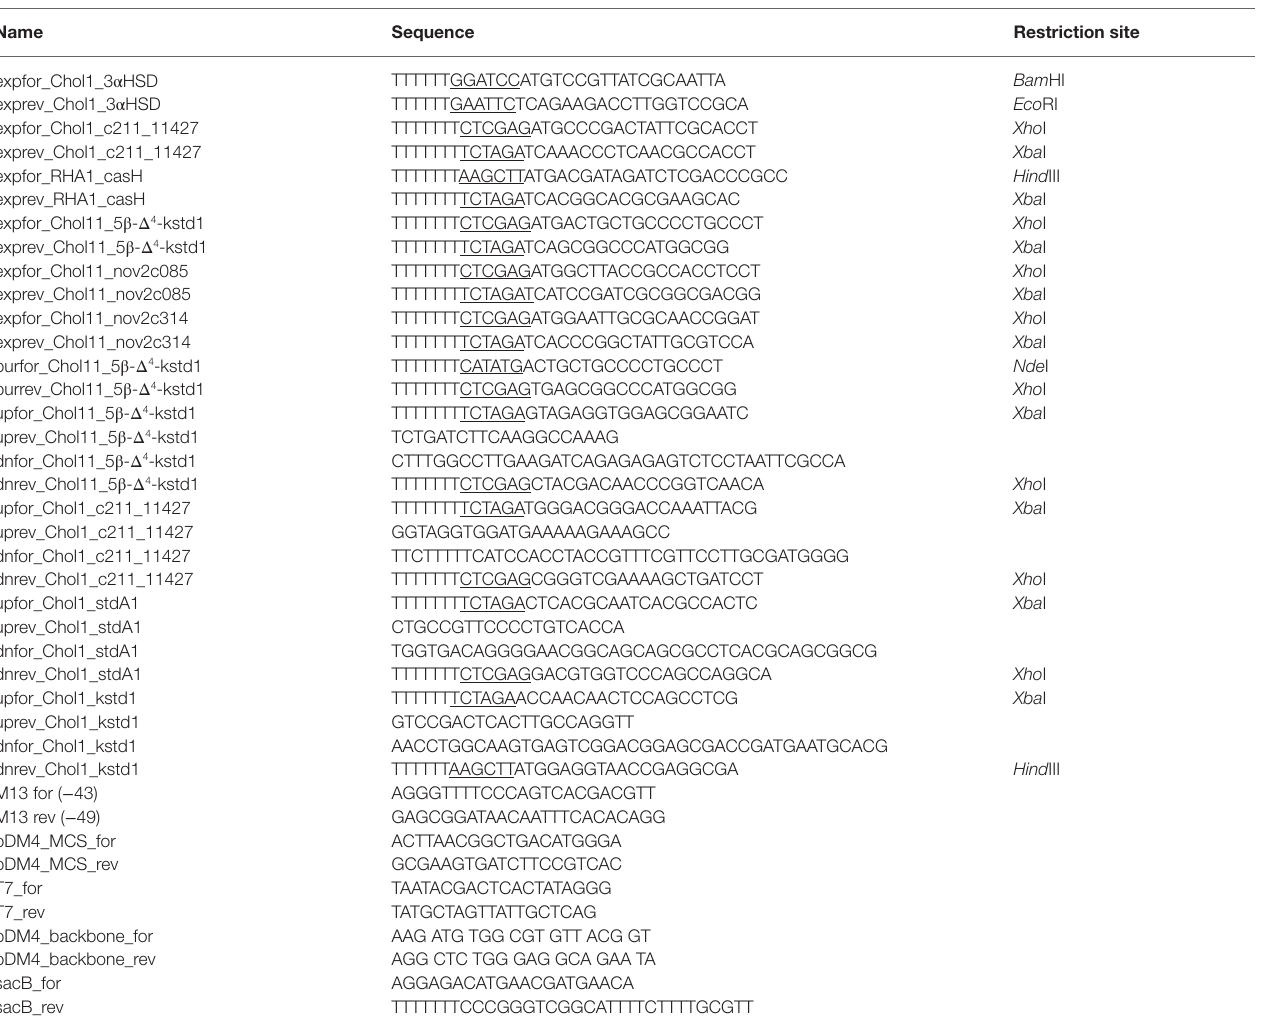
TABLE 2 | Primers used for cloning and construction of unmarked gene